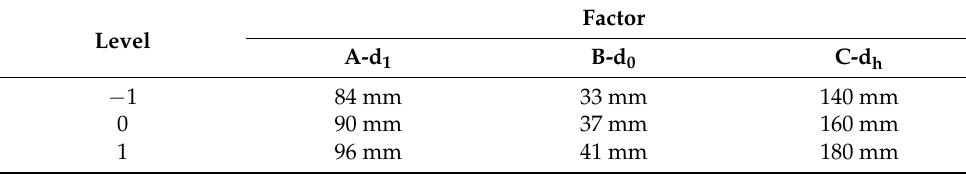
Table 5. Response surface method test design of three factors and three